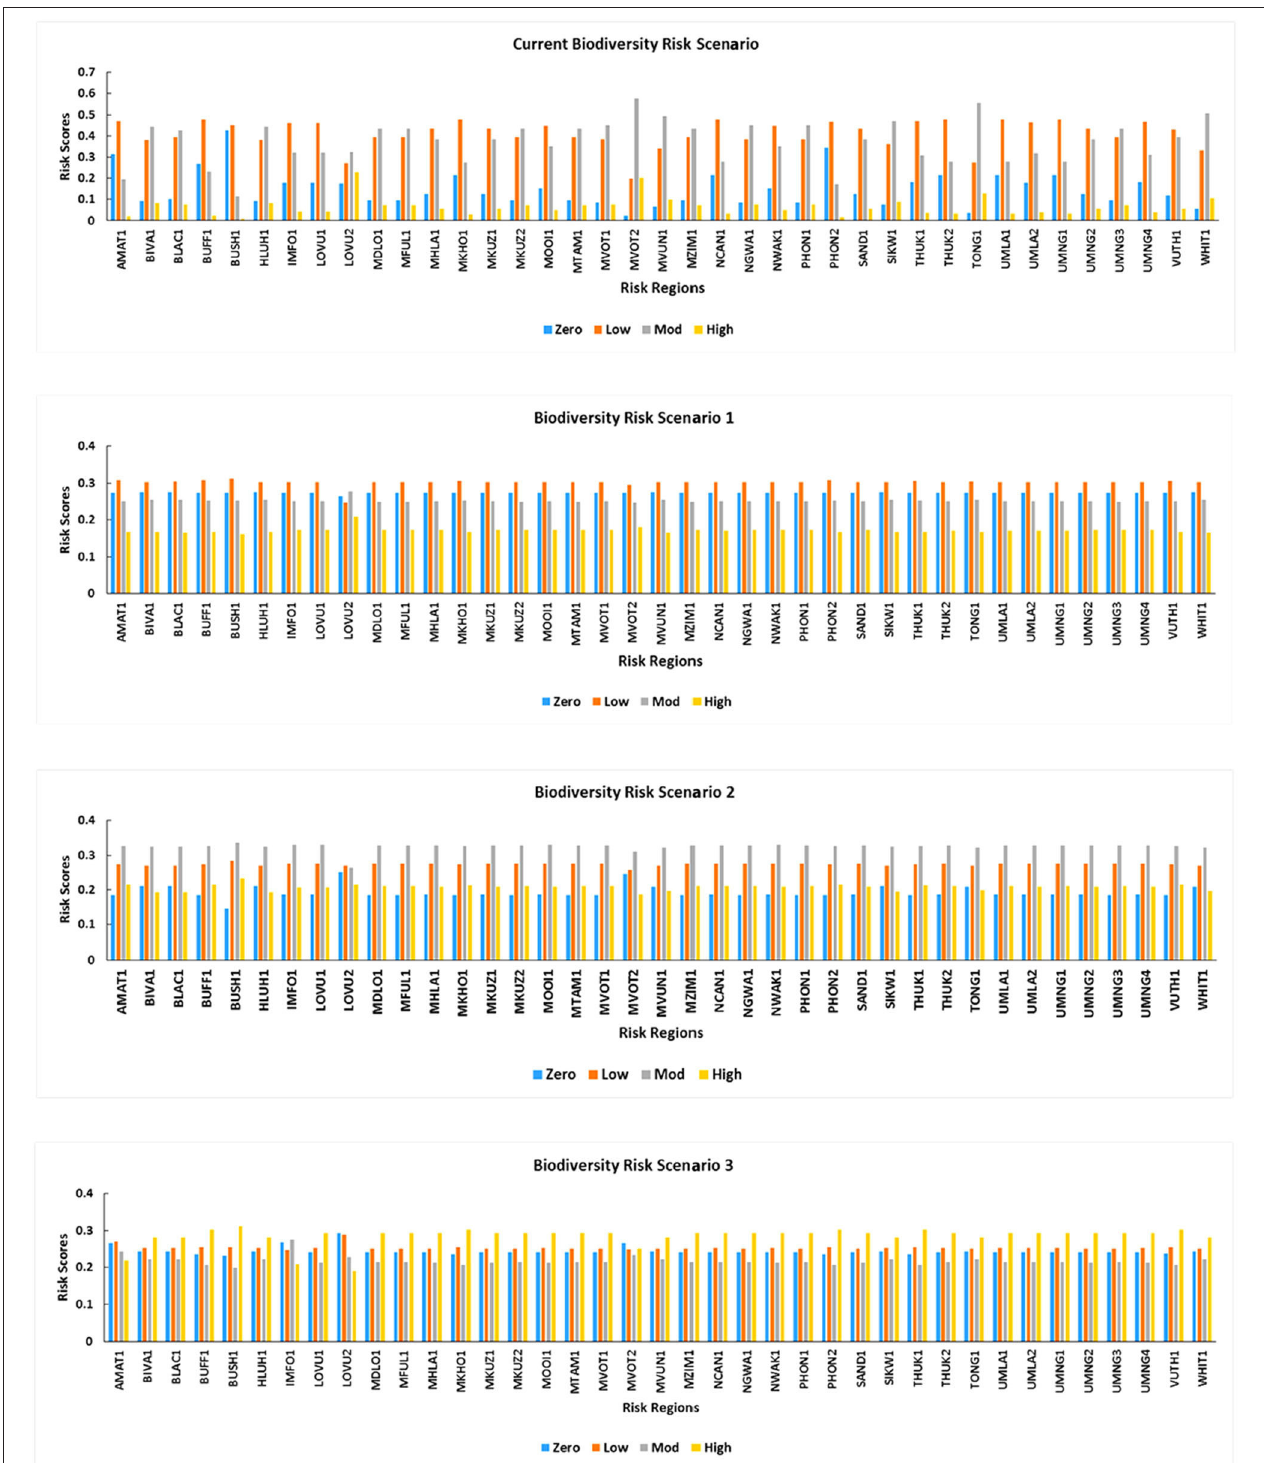
FIGURE 4 | Bayesian network risk distributions across the risk regions and in all scenarios of the biodiversity endpoint.